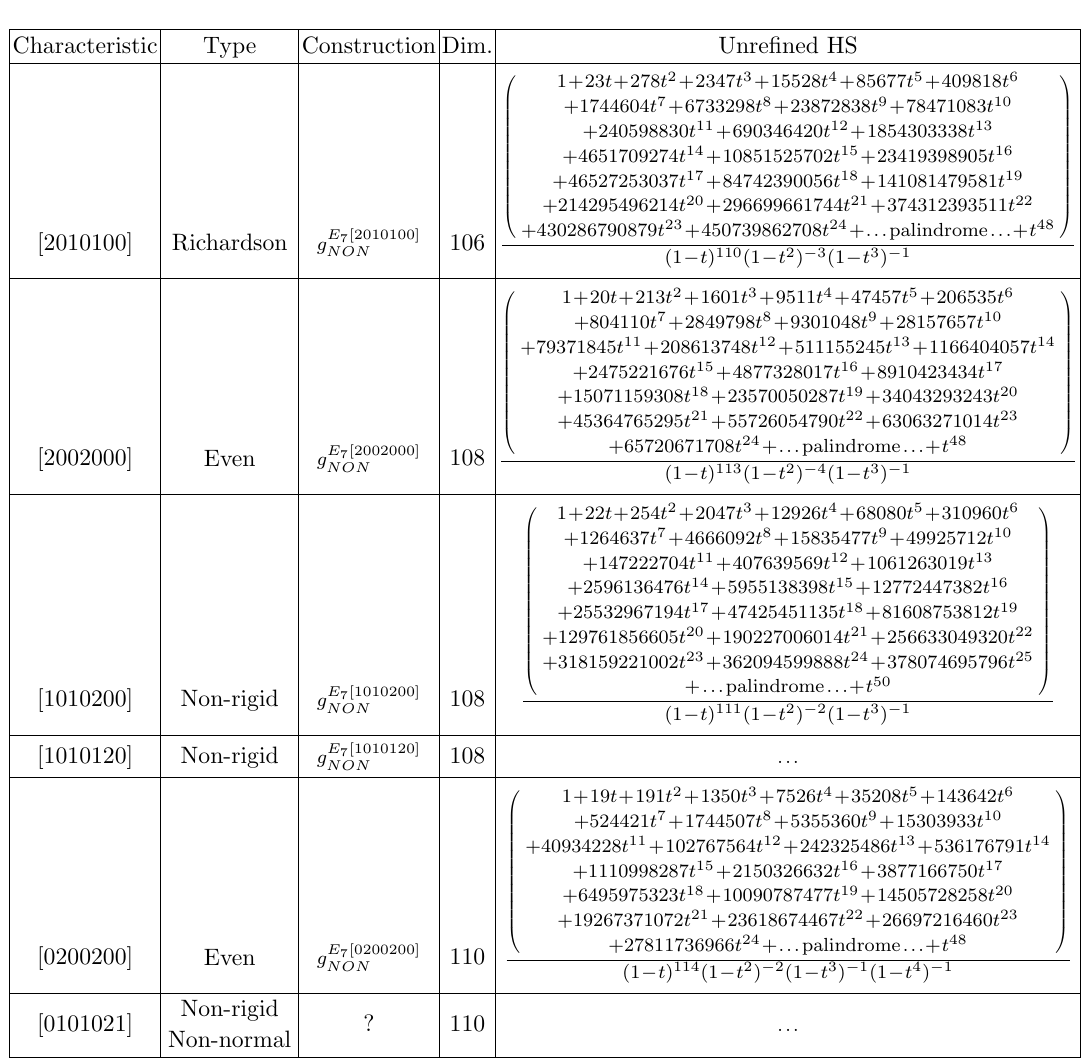
Table 22 . E 7 orbit constructions and Hilbert series (E). Some orbits in the upper Hasse diagram remain to be